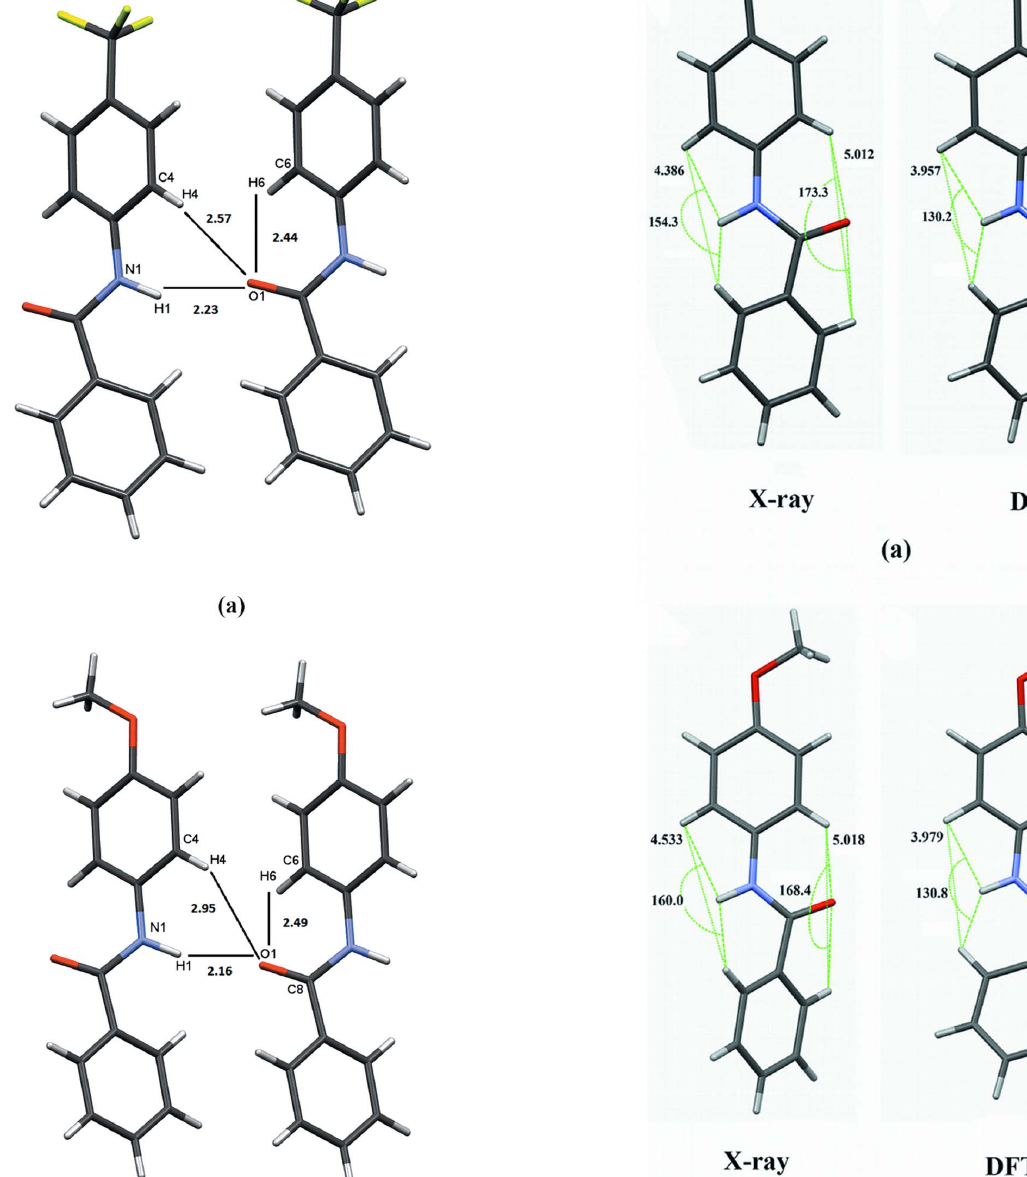
Figure 5 Comparison of hydrogen-bonding environments (in A˚ ) from X-ray results and DFT calculations for ( a ) TFMP and ( b ) MOP